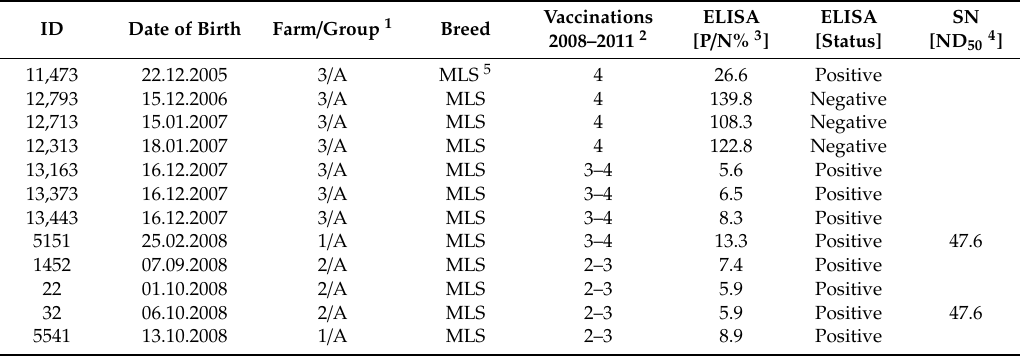
Table 1. Details on animals, history of vaccination, and results of ELISA (BTV group-specific antibodies) and serum neutralization (SN, BTV-8 serotype-specific neutralising